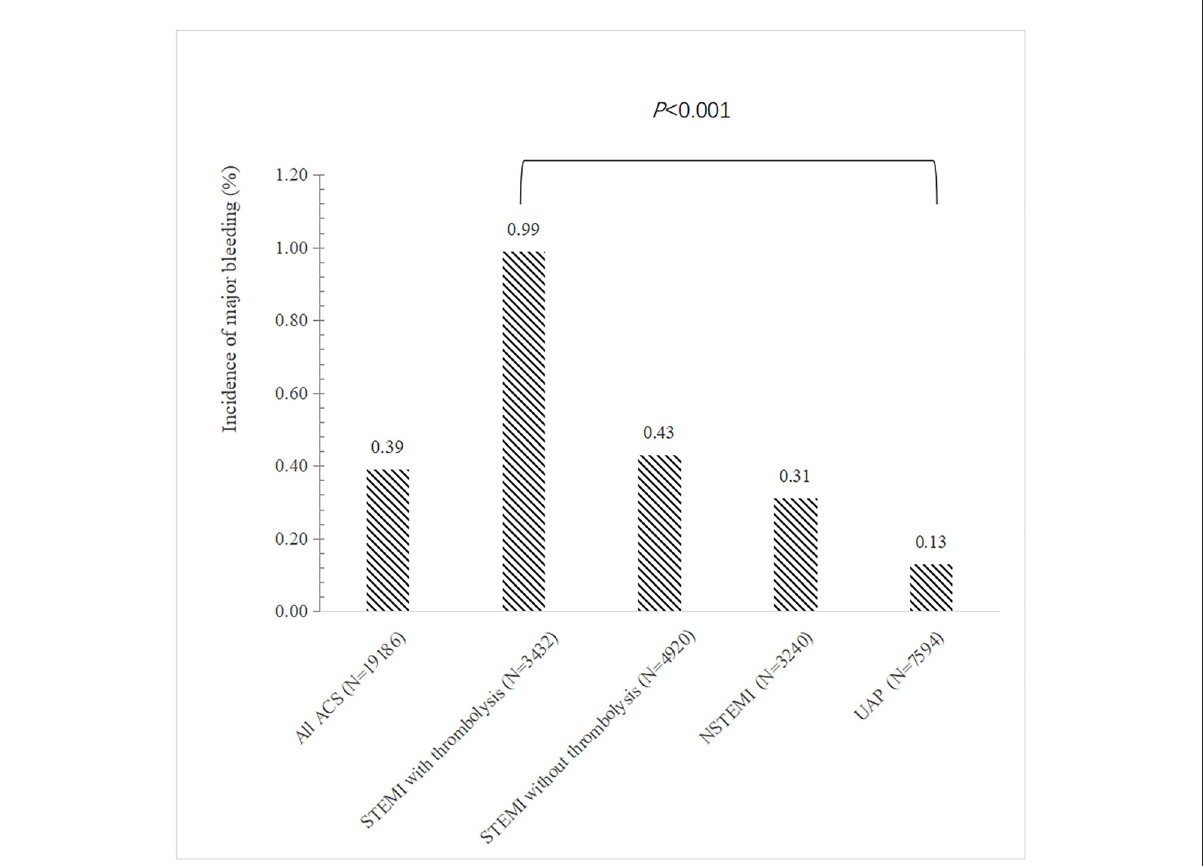
FIGURE1 Incidence of major bleeding according to the type of ACS. The bar showed the incidence of in-hospital major bleeding according to the type of ACS. ACS, acute coronary syndrome; STEMI, ST elevation myocardial infarction; NSTEMI, non–ST-segment elevation myocardial; UA, unstable